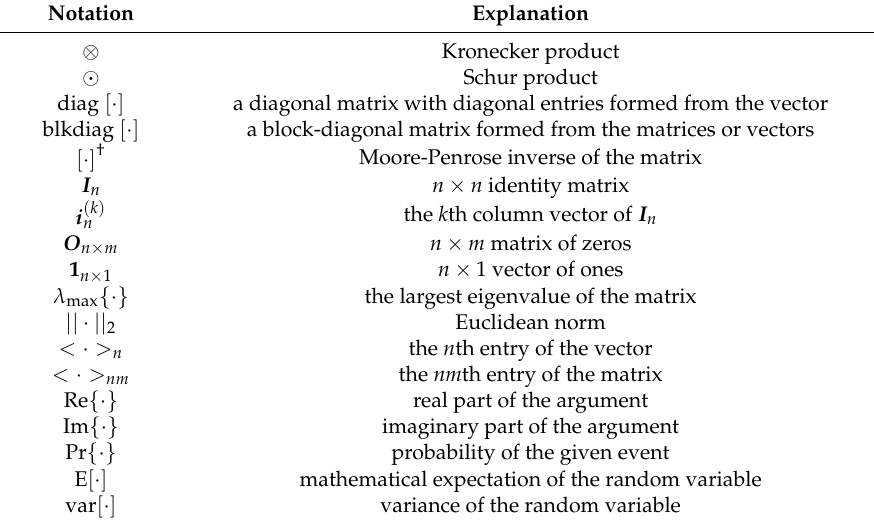
Table 1. Notational